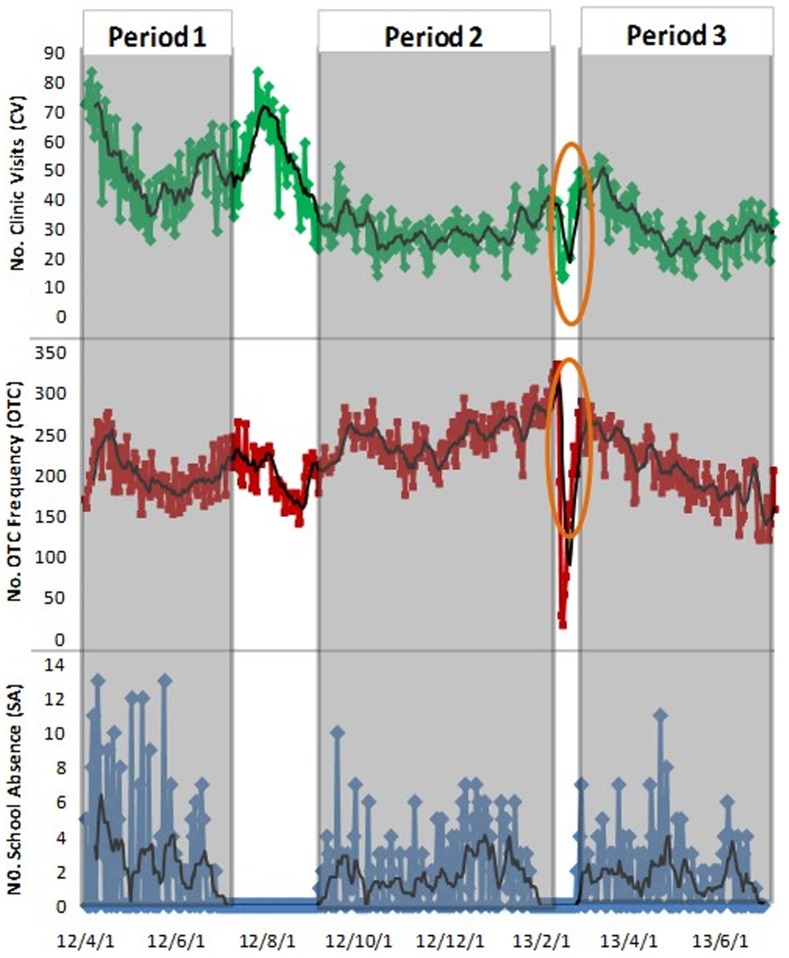
Baselines of three surveillance streams in six towns in Hubei, China, 2012/4/1–2013/6/30.Gray bars show three periods separated by vacation breaks. Circles point out dips during the Chinese New Year.